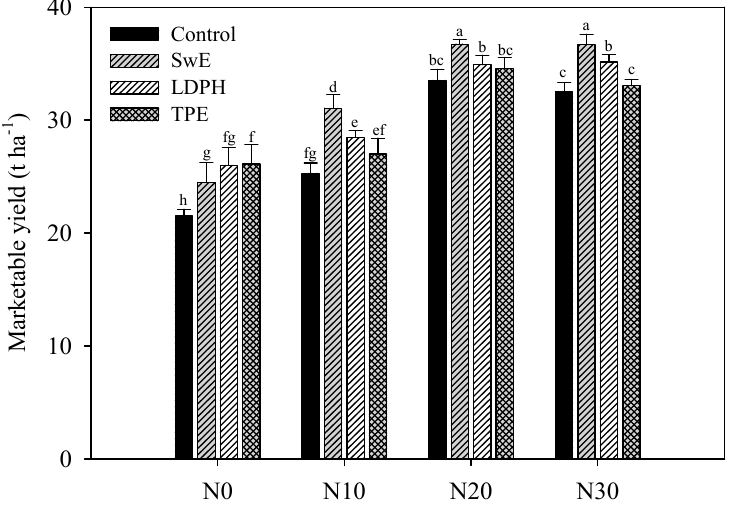
Figure 2. Effects of nitrogen (N) fertilization levels (0, 10, 20 and 30 kg N·ha − 1 ; N0, N10, N20 and N30, respectively) and biostimulant applications (untreated control, SwE: Extract of seaweed Ecklonia maxima , LDPH: Legume-derived protein hydrolysate and TPE: Tropical plant extract) on the marketable fresh yield of baby lettuce plants. Different letters indicate significant differences according to the Duncan’s test (significance level 0.05).